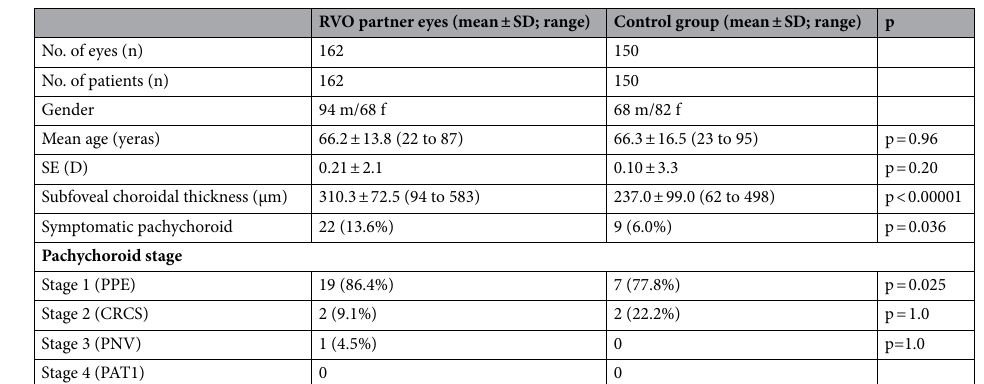
Table 1. Demographic characteristics and the distribution of pachychoroidal features in the RVO group compared to the control group.